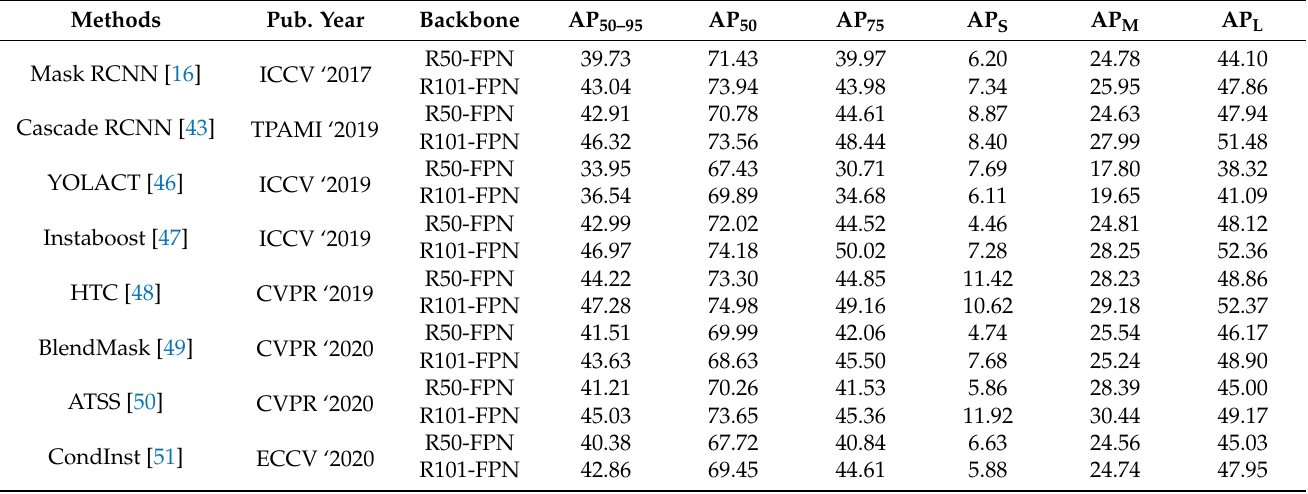
Table 4. The experimental results obtained in cross-sectional comparison conducted on the COD10K dataset (the top three performances are highlighted in red, blue, and green, bold denotes our